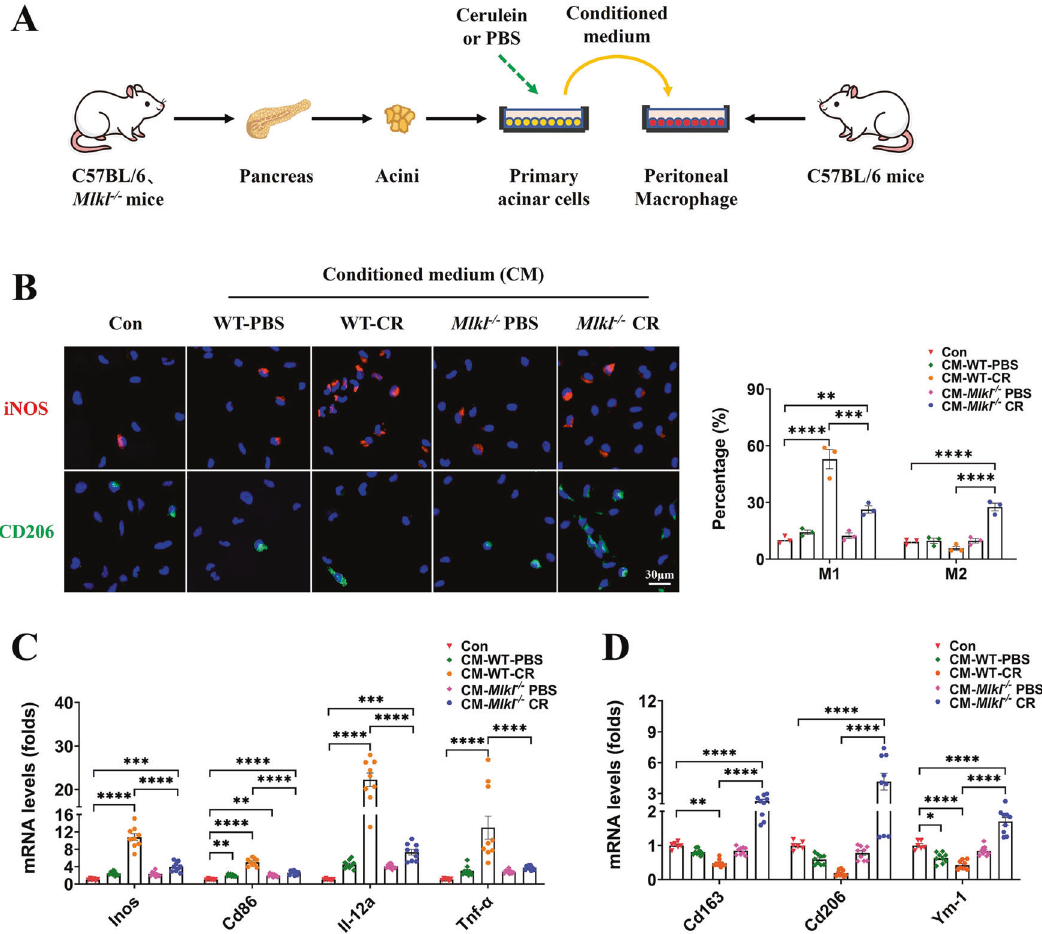
impaired their ability to promote macrophage M1 polarization. A Schematic diagram for constructing an indirect coculture system of pancreatic acinar cells and peritoneal macrophages. B Immuno fl uorescence staining of iNOS (red) and CD206 (green) in peritoneal macrophages ( n = 3). C , D mRNA levels of M1 macrophage markers ( Inos, Cd86, Il-12a, Tnf- α ) and M2 macrophage markers ( Cd163, Cd206, Ym-1 ) in peritoneal macrophages. Data were normalized to GAPDH ( n = 6-9). Values are shown as the means ± SEMs. ns, not signi fi cant; * P <